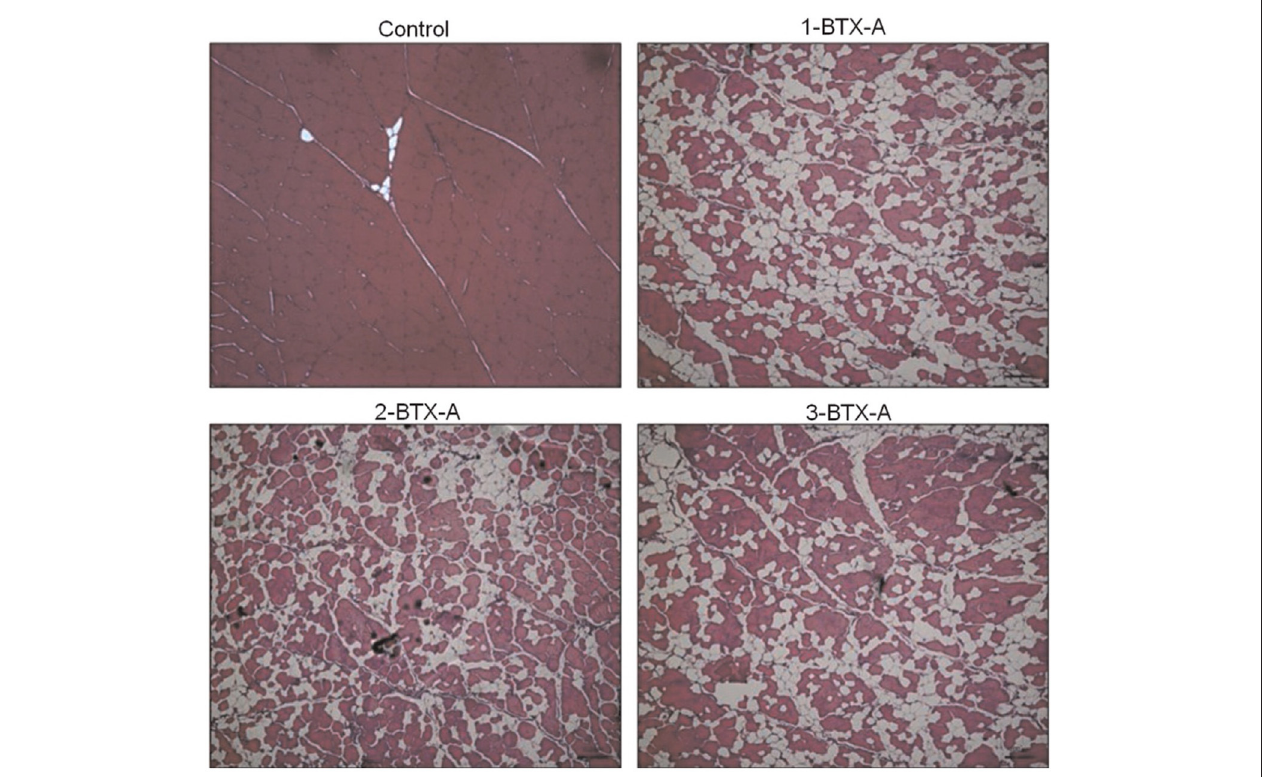
FIGURE 13 | Exemplar histology slides of muscles injected with Botulinum toxin type-A (BoNT-A). Control tissue that was injected with a corresponding volume of saline (Control), muscle receiving one BTXA injection evaluated 6 months following injection (1-BTX-A), muscle receiving two BTXA injections separated by 3 months and evaluated 6 months post the second injection (2-BTX-A), and muscle injected three times with BTXA, separated by 3 months and evaluated 6 months following the third and last injection. The red staining shows the contractile material of the muscle. The white, thin lines (especially visible in the Control slide) are representative of the collagen matrix structure, and the white extended areas (especially visible in the BoNT-A injected muscles) represent intramuscular fat. The average percentage of contractile tissue in these muscles were 96.9 ± 2.0% (Control), 59.2 ± 6.0% (1-BTX-A), 62.5 ± 6.1% (2-BTX-A), and 59.9 ± 11.8% (3-BTX-A),